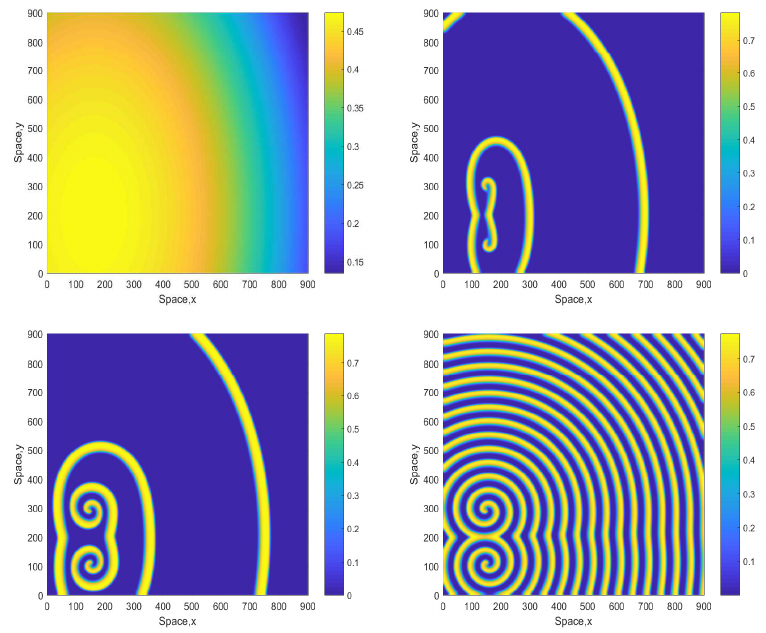
Figure 9. Spatial distribution of the oxygen concentration obtained for A = 2.4 and shown for t = 1, t = 120, t = 200 and t = 3000 (left to right, top to bottom). The other parameters are the same as above. The initial conditions are given by Equations (13)–(15) with c 0 = 0.4723, u 0 = 0.3612 v 0 = 0.1554.